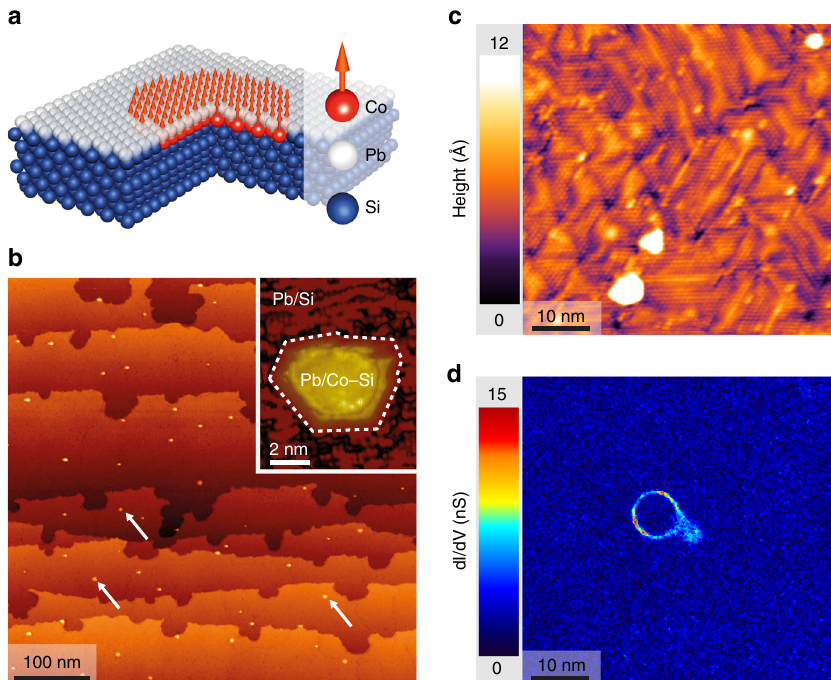
Fig. 1 Superconducting-ferromagnetic hybrid system Pb/Co/Si(111). a Schematic structure of the system investigated by STM. A monolayer of Pb is grown on top of Si(111) at the surface of which magnetic disks of Co – Si have grown. b Large scale topography of the sample after a long annealing at 400 °C which provokes the formation of a Pb defected mosaic phase everywhere and reveal the buried Co – Si clusters. The magnetic clusters are revealed as small dots of 5 – 10 nm width. Inset: zoom on such a revealed Co – Si cluster. A highly inhomogeneous and defective Pb/Si(111) mosaic phase is seen outside the island. c Topography of a 63 × 63 nm 2 area measured by scanning tunneling microscopy (bias voltage − 50 mV, tunnel current 30 pA). The atomic pattern and corrugation reveals a striped-incommensurate Pb/Si(111) monolayer. A buried Co – Si cluster is present in this area below the monolayer but it does not appear in the topography. d d I /d V ( V ) conductance map at 1.32 meV measured at 300 mK on the area shown in image c . The experiment was performed with a superconducting Pb tip, thus the energy is shifted by the gap of the tip. Once deconvoluted from the tip density-of-states, the map displays ring-shaped in-gap states located at the Fermi level (see text and Supplementary Fig. S1 for details). Thus, the ring-like feature corresponds to a gapless region but everywhere else a hard superconducting gap is present as evidenced by the homogeneous dark-blue color (low